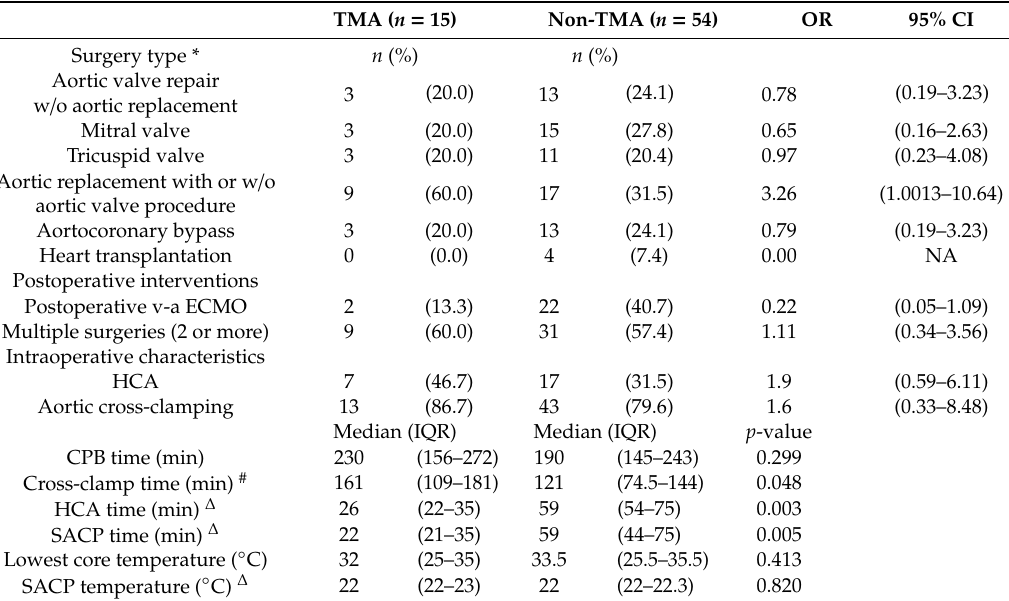
Table 3. Surgery